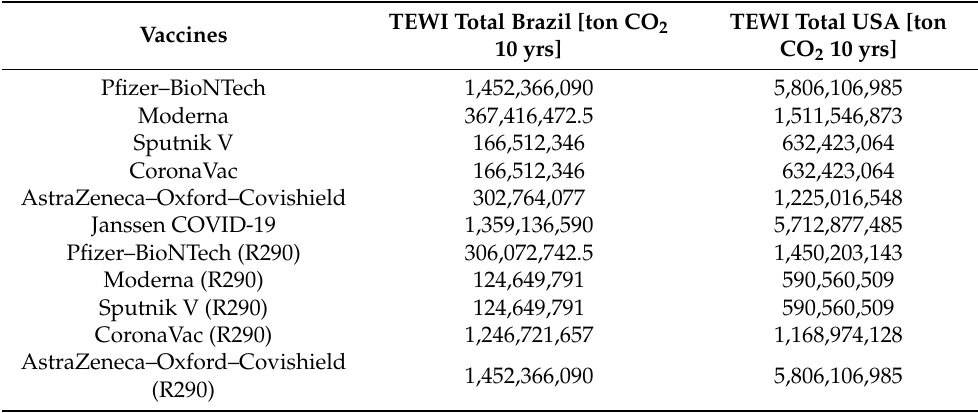
Table 9. Vaccine TEWI world